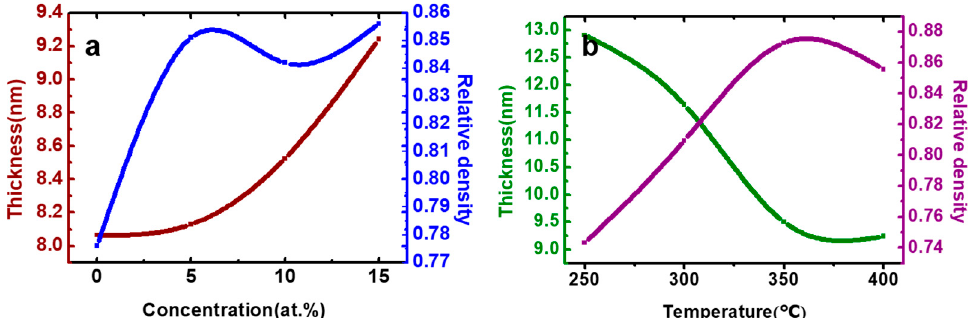
Figure 3. ( a ) Thickness and relative density changes with the Zr doping concentration annealed at 400 °C. ( b ) Thickness and relative density changes with the annealing temperature at 15 at.% Zr doping concentration.